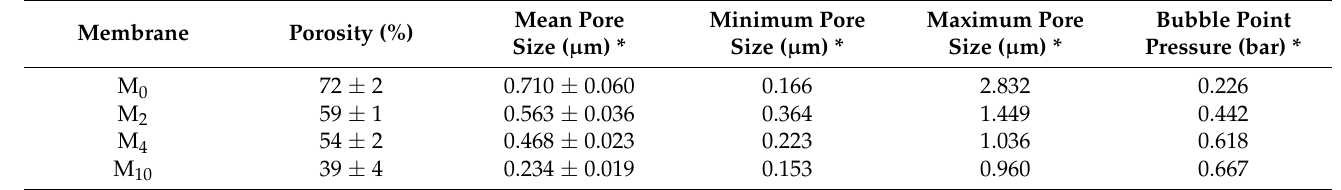
Table 4. The influence of the gelation time on the membrane porosity and mean pore size.